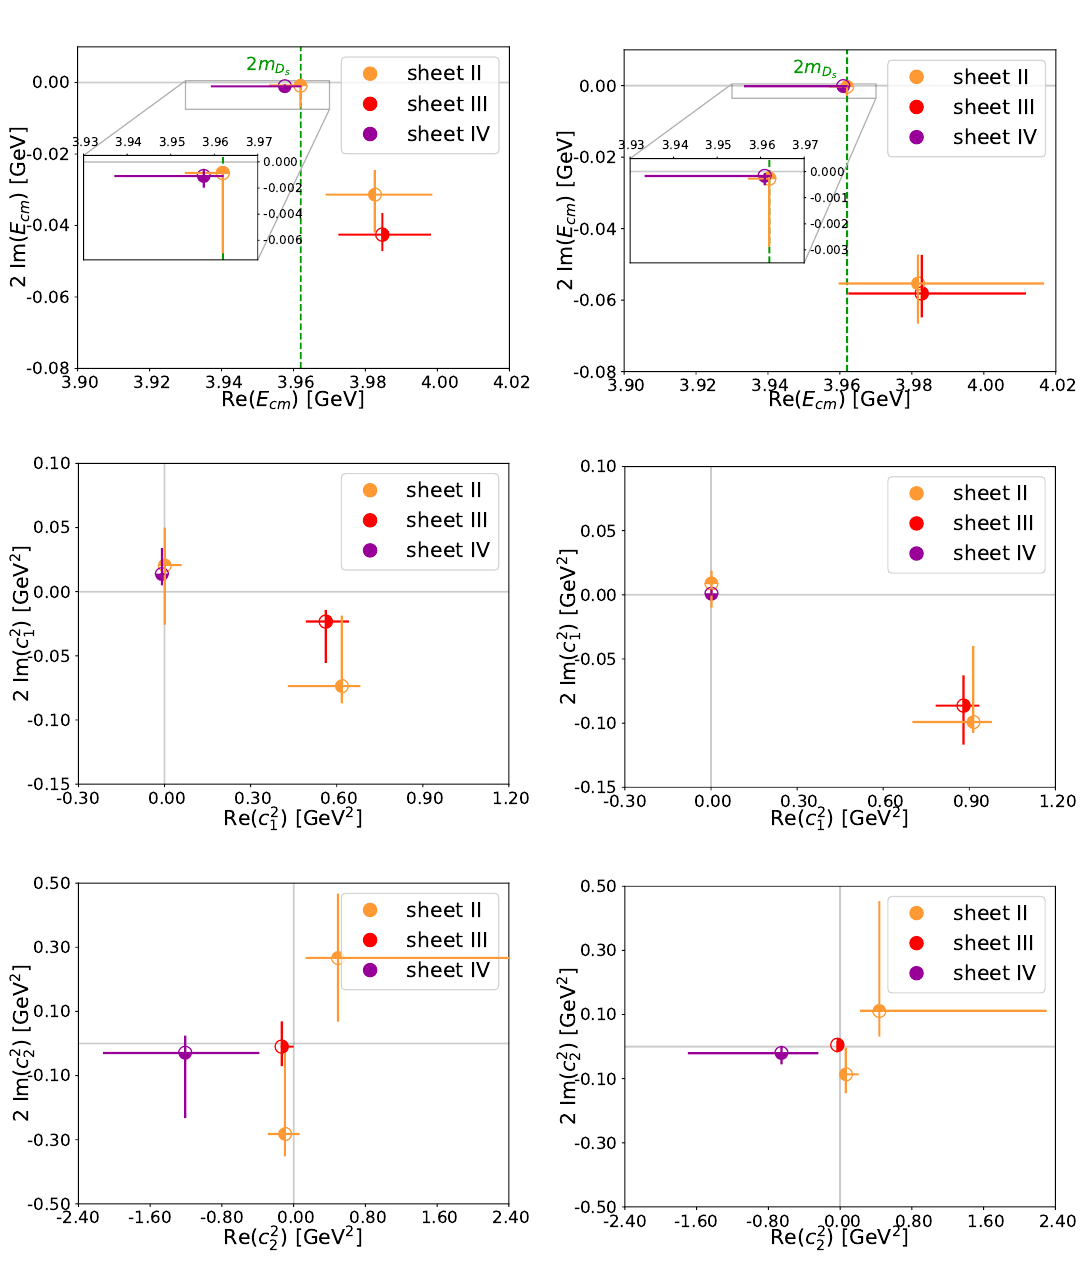
Figure 6 . Coupled channel D ¯ D , D s ¯ D s scattering in partial wave l = 0 : the analysis omitting l = 2 (left) and including l = 2 (right). Top: location of the poles in t ij (8.13), (8.14), (8.15) in the complex energy plane. The orange poles are on Riemann sheet II, the magenta poles are on sheet III and the violet poles are on sheet IV (see eq. (2.4)). There is only one pole near the D s ¯ D s threshold for each bootstrap sample and it appears either on sheet II or the nearby sheet IV. The green dashed line denotes the D s ¯ D s threshold with m D ’ 1981 MeV. Middle and bottom: s the couplings c 2 to channels i = 1 ( D ¯ D ) and i = 2 ( D s ¯ D s ) as extracted from the respective pole i residues according to eq. (2.5). The symbol fillings distinguish the two orange